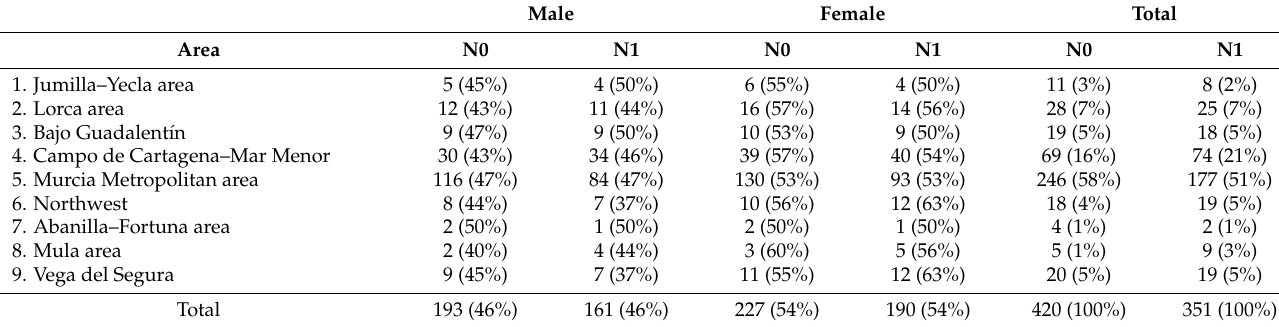
Questionnaire completion rate of the study population stratified by gender and geographical